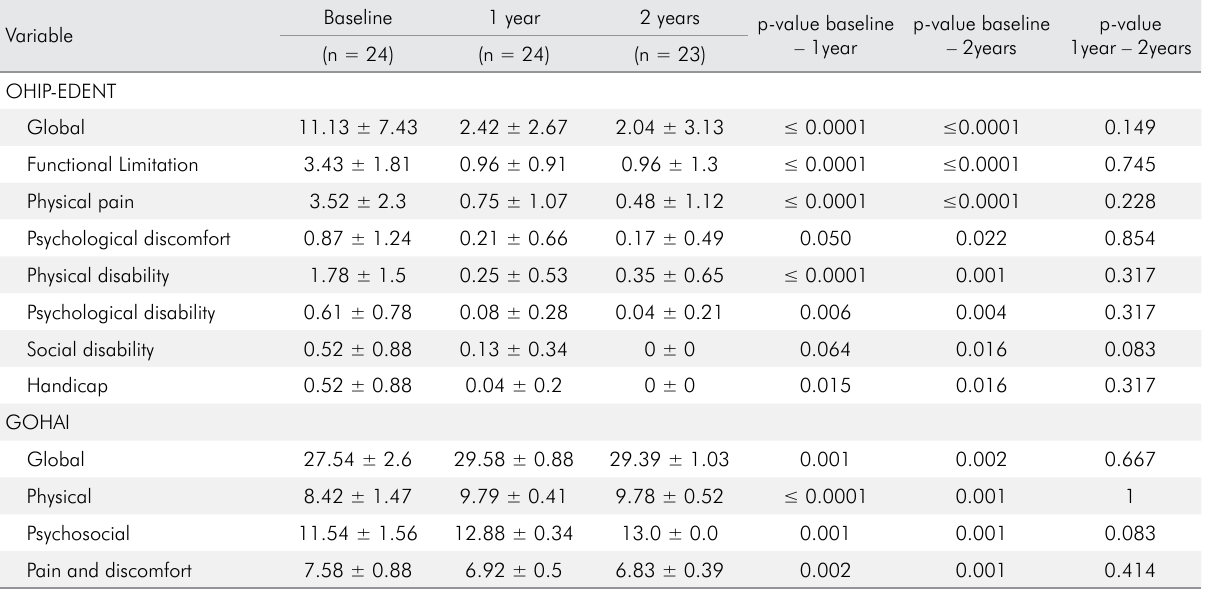
Table 3. Means and standard deviations of the OHIP-EDENT and GOHAI questionnaire domain scores before, after 1 year and after 2 years of MO loading. (Wilcoxon Paired Test, p <